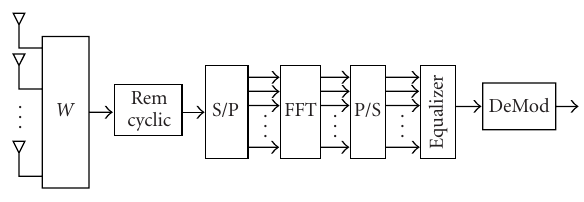
Figure 1: Block diagram of a baseband OFDM time domain re- ceiver, adapted from [1] with addition of receiver